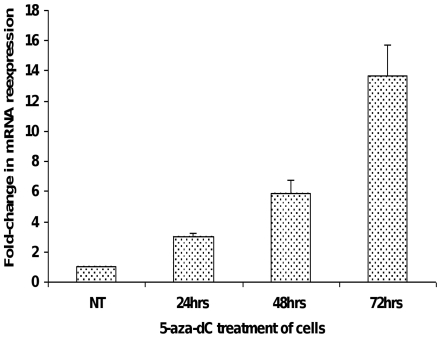

CLDN11 mRNA re-expression in AGS GC cells after 5-aza-2′-deoxycytidine (5-aza-dC) treatment.AGS is a GC cell line manifesting hypermethylation of the CLDN11 promoter in conjunction with absent CLDN11 mRNA expression. These cells were treated with 5-aza-dC, a global demethylating agent. Total RNA from AGS cells before and after 5-aza-dC treatment were subjected to quantitative real-time RT-PCR analysis for CLDN11 mRNA expression. The Y-axis represents the average fold change in expression levels of CLDN11 mRNA after 5-aza-dC treatment at various time points, when compared with the untreated cells. AGS cells, when treated with 5-aza-dC, exhibited a time-dependent increase in CLDN11 mRNA expression up to 72 hrs of treatment. This restoration of CLDN11 expression after 5-aza-dC treatment supports our hypothesis that claudin-11 is silenced by promoter hypermethylation in GC cells.